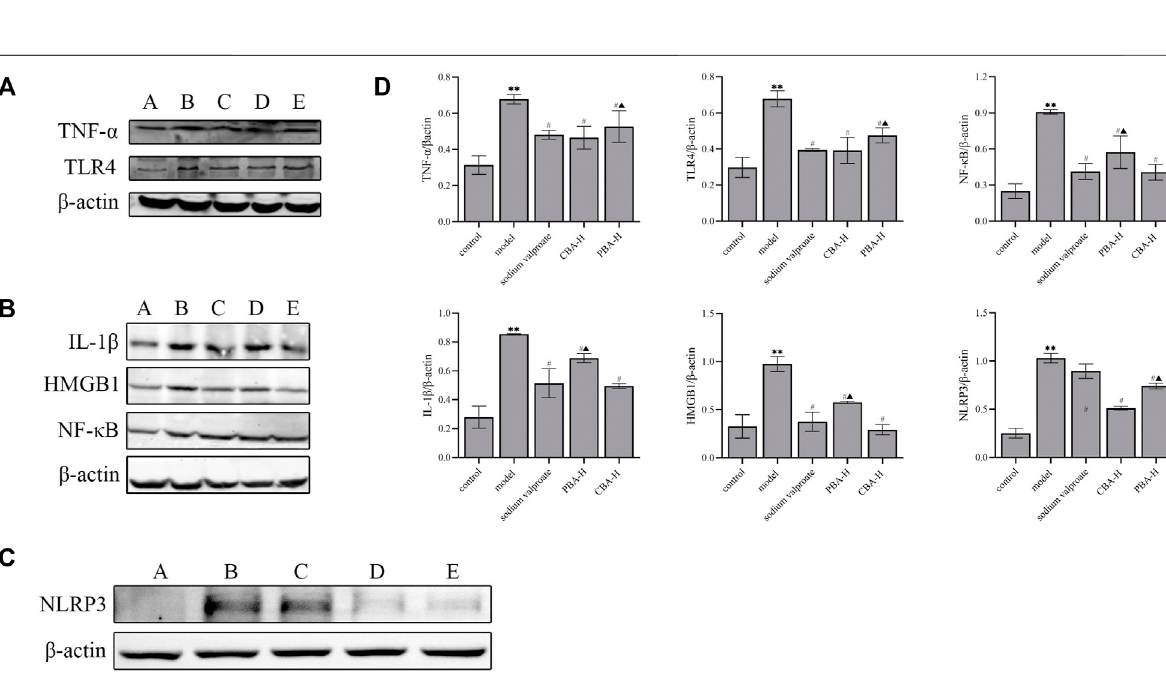
Frontiers in Pharmacology |